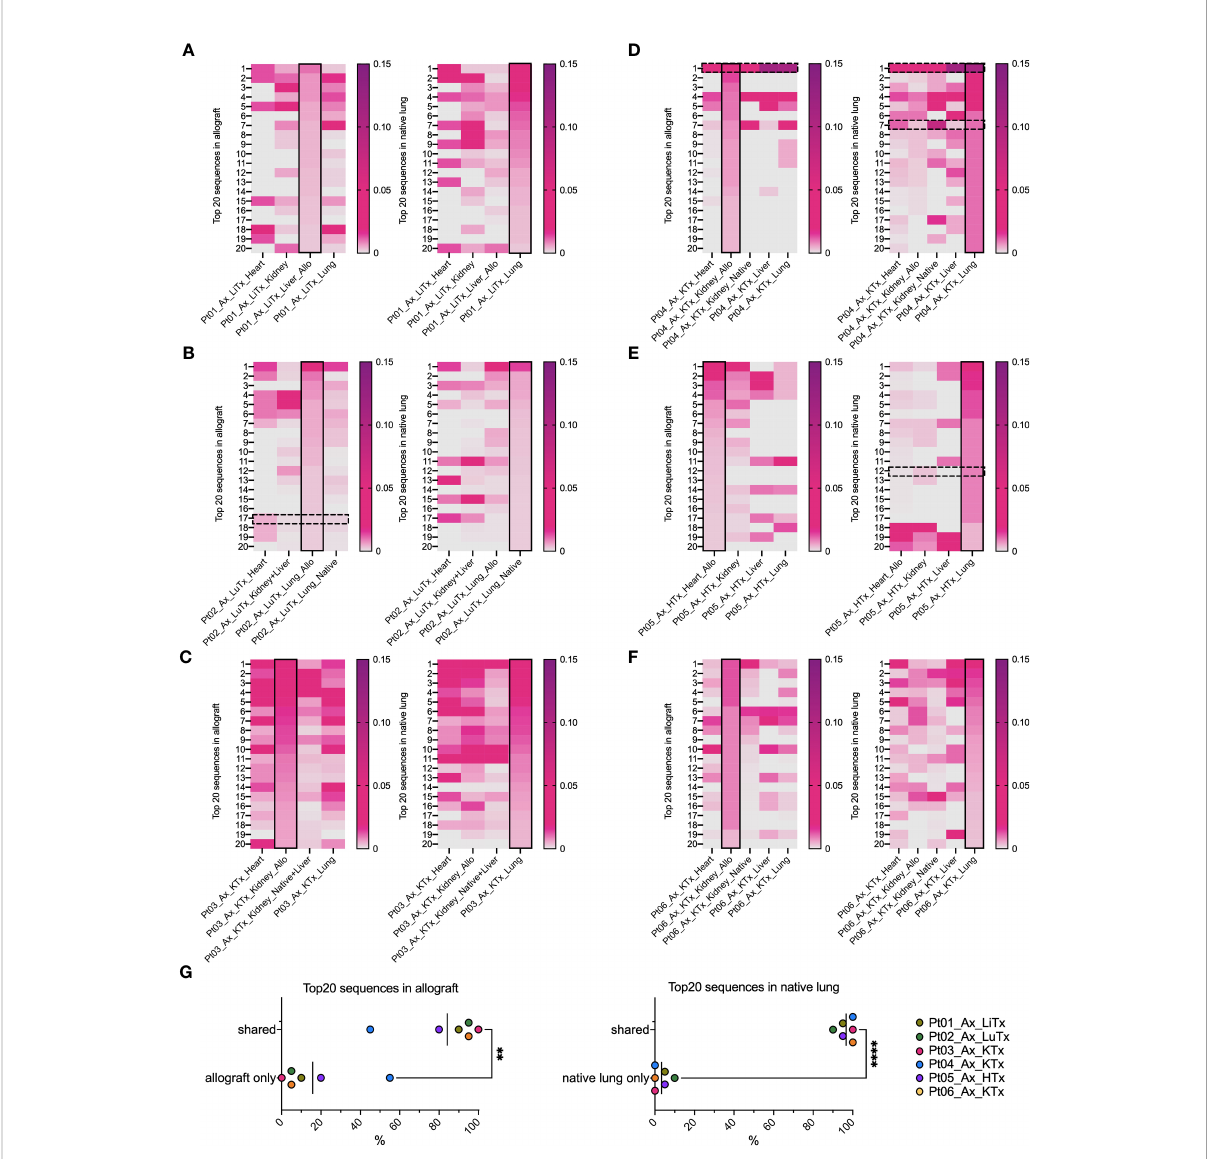
FIGURE 4 Top 20 dominant TCR clonal distribution and overlap in allografts and native lungs in individual patient ’ s autopsy specimens. In each heatmap panel (A – F : Pts01-06), solid black rectangle in column highlights top 20 dominant TCRs in each row ranking by frequency (ranges from 0-0.15) within that designated sample, either allograft (left panel) or native lung (right panel) of each patient. Black dashed line rectangles indicate rows with COVID-associated TCR sequences detectable in Pts02, 04, 05 in reference to ImmunoSEQ T-MAP COVID database. (G) Percentages of top 20 dominant clones in allograft present in “ allograft only ” and “ shared ” by allograft and native tissues were summarized in left panel. Percentages of top 20 dominant clones in native lung present in “ native lung only ” and “ shared ” by allograft and native tissues were summarized in right panel. Paired t test was applied to determine statistical signi fi cance (**p<0.01,